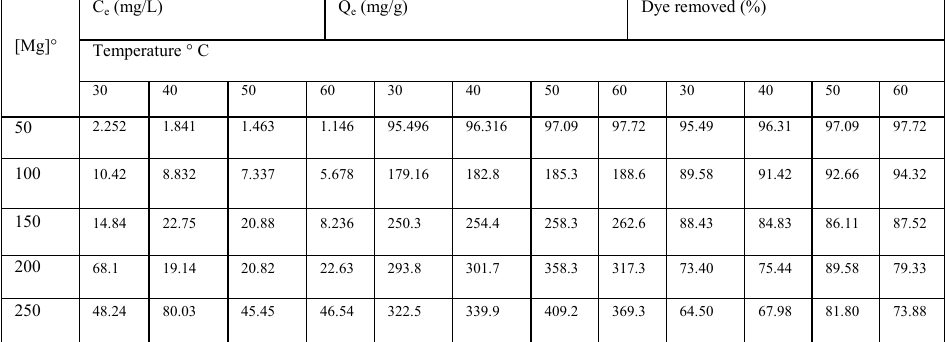
Table 2. Equilibrium parameters for the adsorption of Dye onto activated